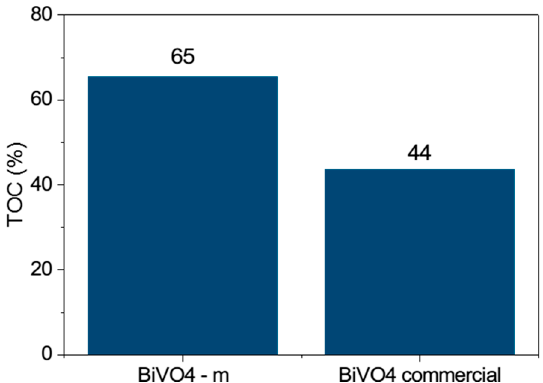
Figure 14. Total Organic Carbon (TOC) percentage of methylene blue dye for BiVO 4 microspheres calcined at 400 °C.